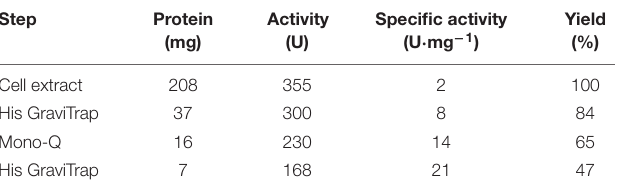
TABLE 3A | Purification of Rj 3HB6H produced in R. jostii RHA1#2.